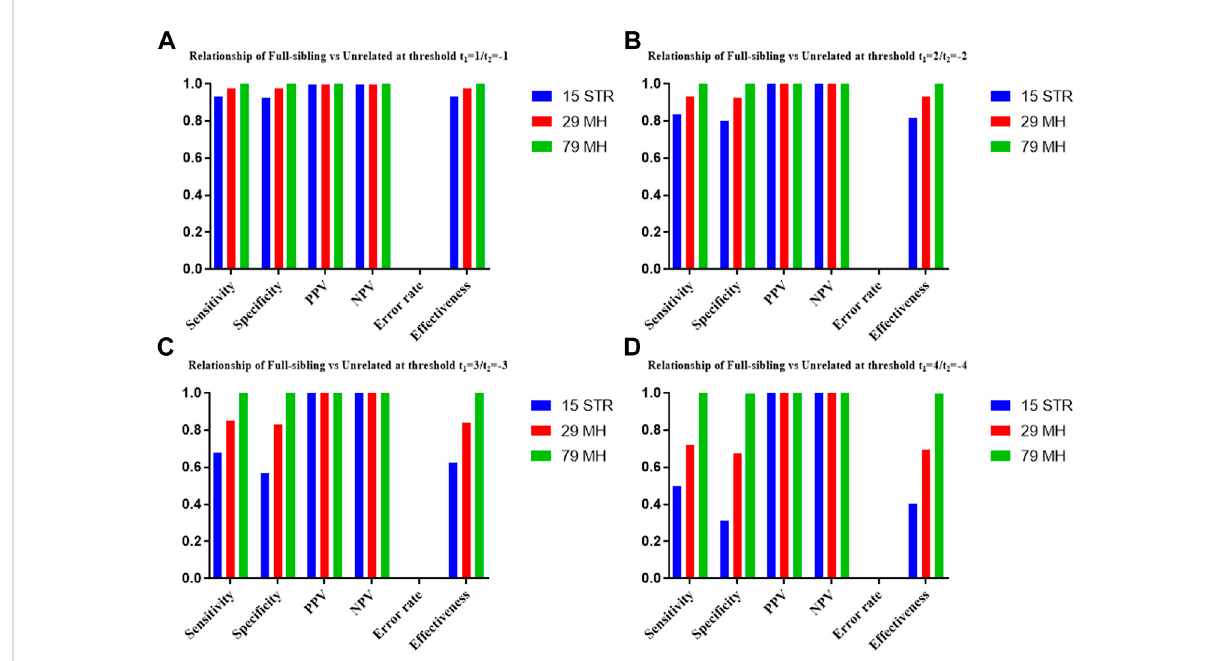
FIGURE 6 Thesystempowerbasedonthedata of15STRloci,29microhaplotypelociand79microhaplotypelociforrelationshipfull-siblingvs.unrelated individuals at different threshold values. (A) Threshold t 1 = 1/t 2 = − 1; (B) Threshold t 1 = 2/t 2 = − 2; (C) Threshold t 1 = 3/t 2 = − 3; (D) Threshold t 1 = 4/t 2 = − 4.